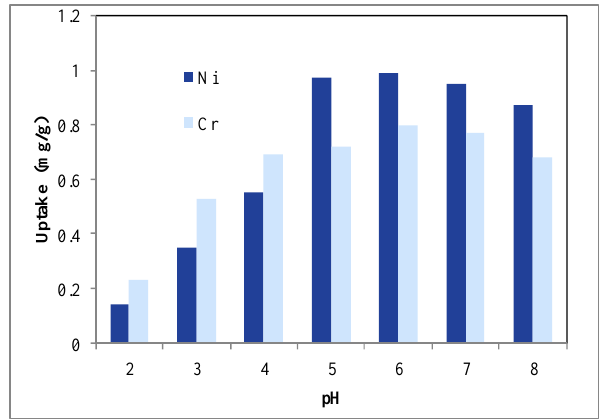
Figure 1. Effect of pH on the uptake of nickel and chromium by zeolite/biofilm (C0 = 10